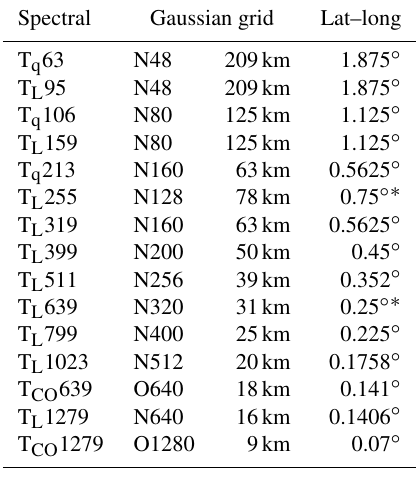
∗ As GRIB1 only supports three decimals, ECMWF recommends to round the resolutions to 0 . 75 ◦ in the case Table